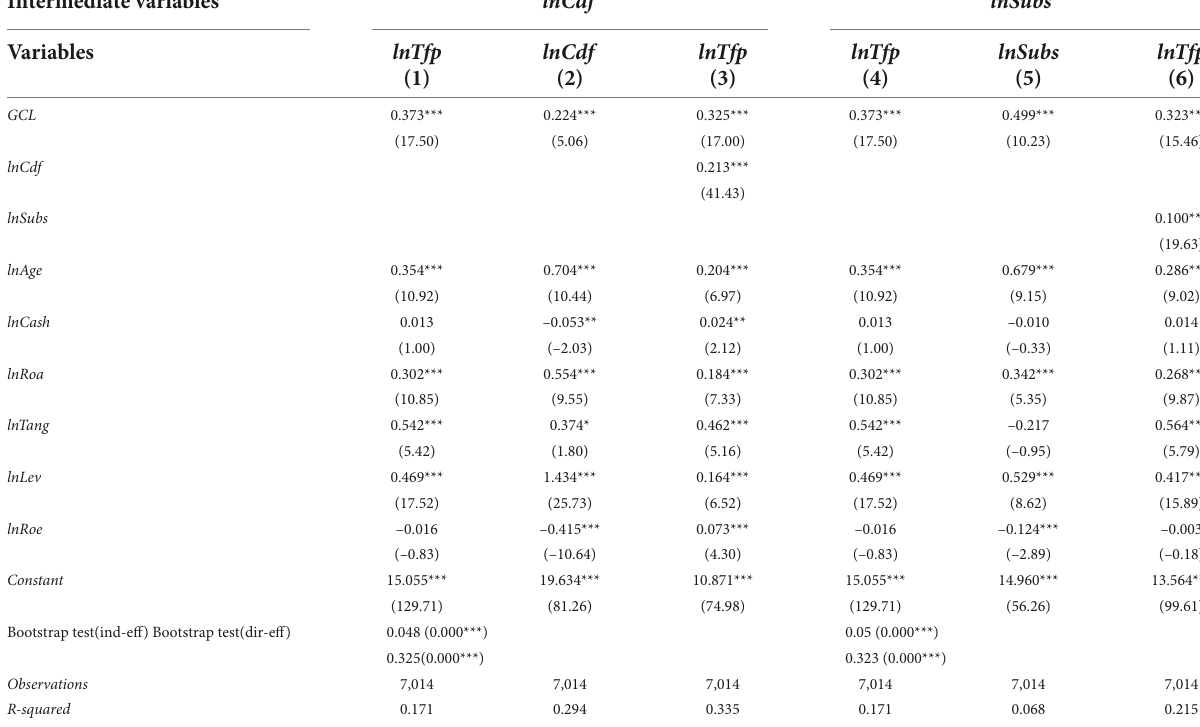
TABLE 7 Stepwise regression results of intermediation